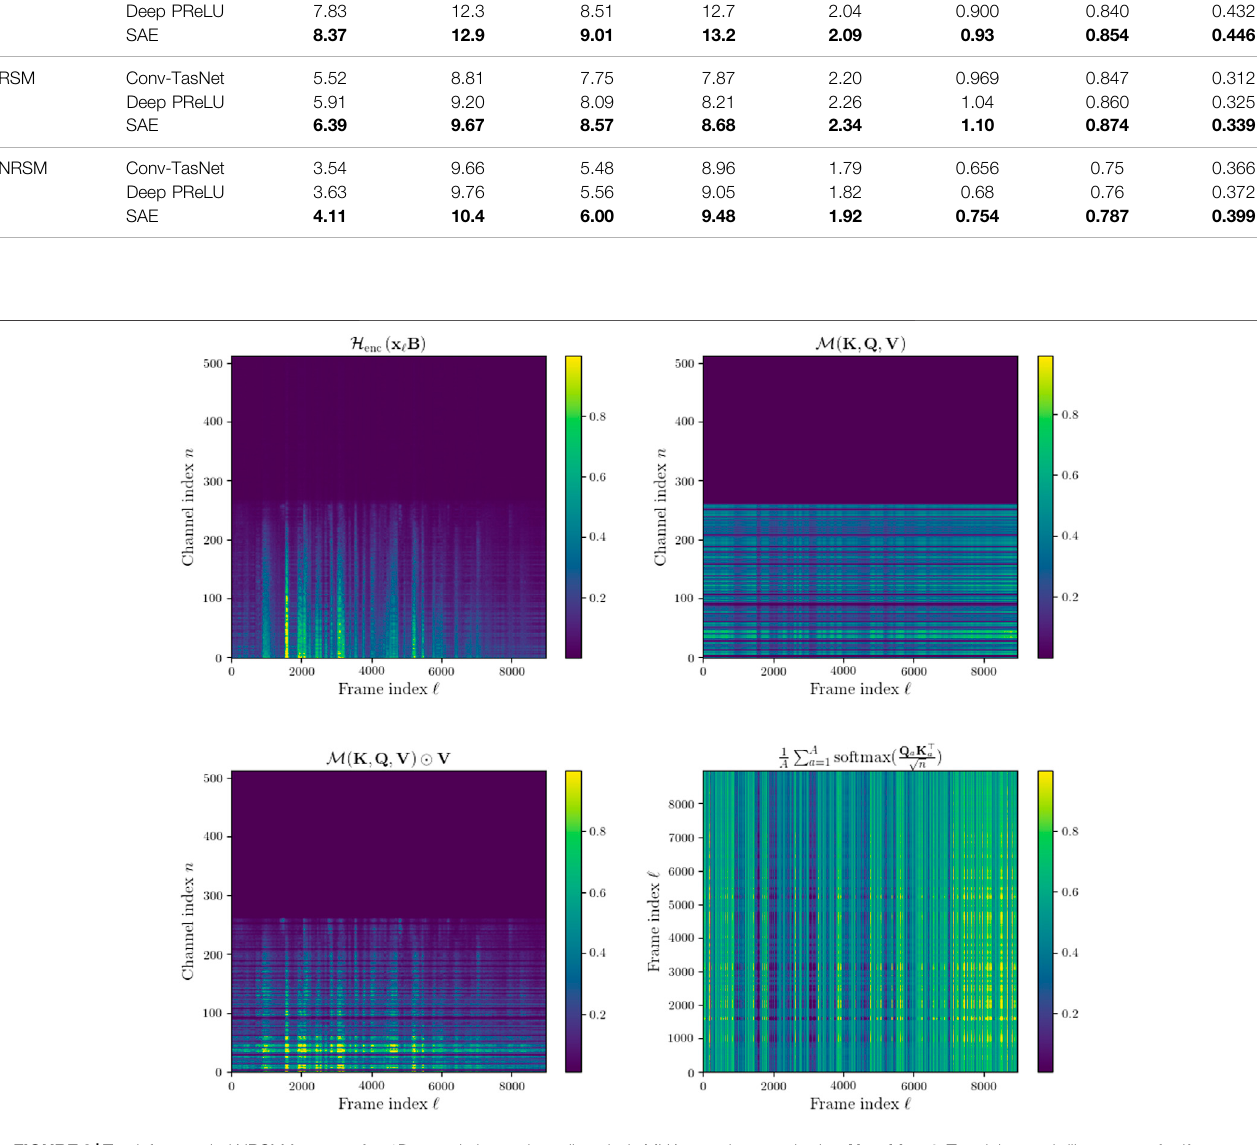
Frontiers in Signal Processing |